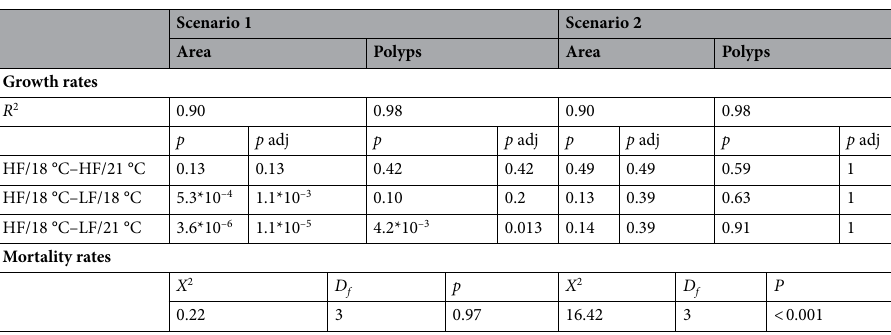
Table 1. Statistical results of growth and mortality rates of juvenile H. echinata over time in scenario 1 and 2. HF = high food, LF = low food, 18 °C = control temperature, 21 °C = high temperature. Significant values are shaded grey. The upper table contains the p -values ( p ), adjusted p-values ( p adj.) and coefficient of determination ( R 2 ) of pairwise comparison (Wilcoxon test) with multiple-testing adjustment (Bonferroni- Holmes) of area and polyp growth. The bottom part of the table shows Chi-squared ( X 2 ), degrees of freedom ( D f ) and p-values ( p ) of the test for equality of proportions of the mortality rates. N Total = 77 for scenario 1and 40 for scenario 2.